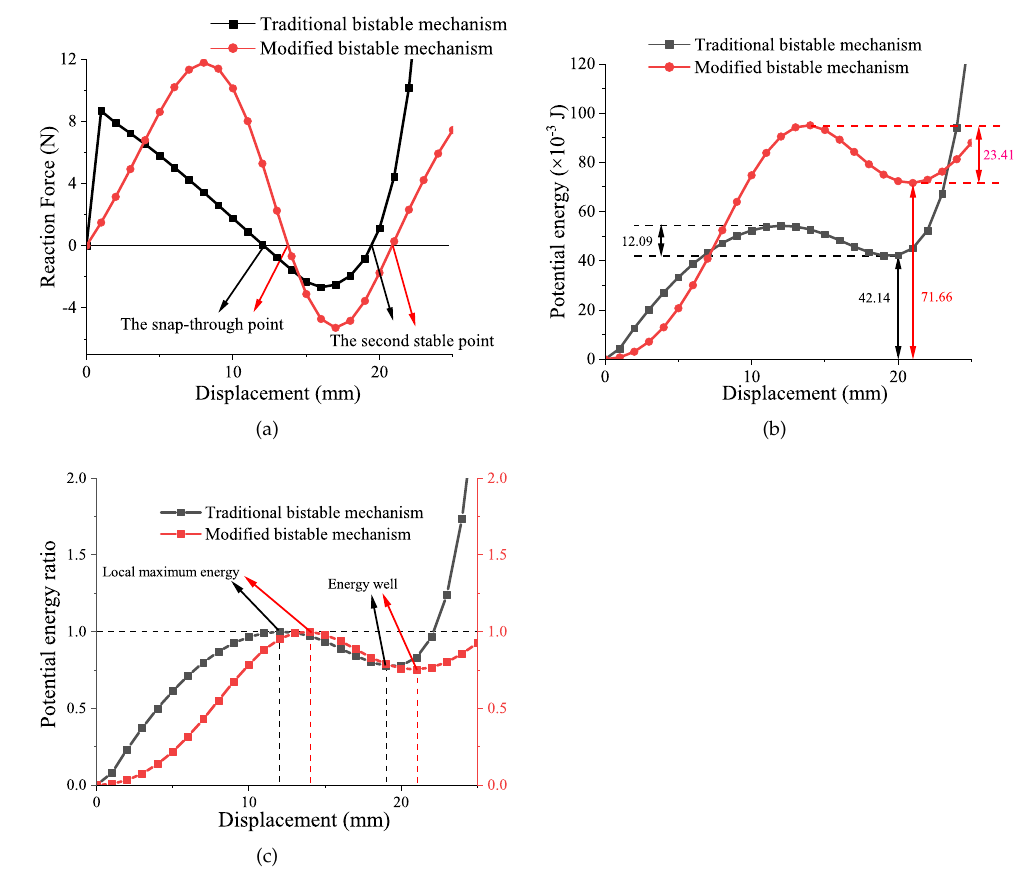
Figure 7. The comparison between the generalized bsitable mechanism and the traditional bistable mechanism: ( a ) the relationship between reaction forces and displacement; ( b ) the potential energy of mechanisms; ( c ) the ratio of potential energy compared to its local maximum